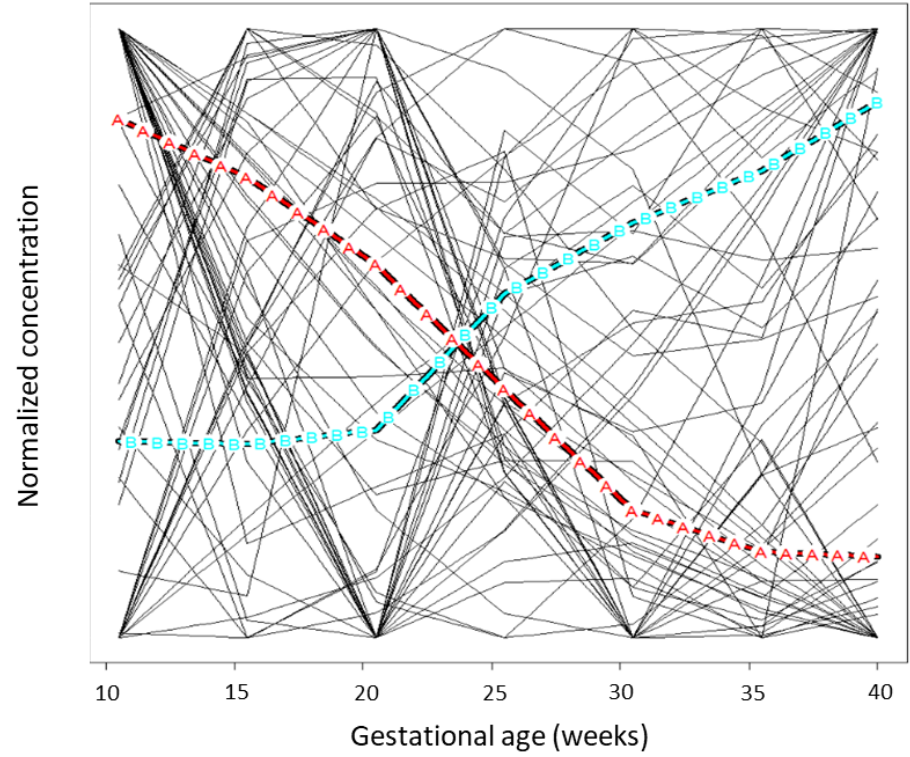
Figure 4. The two groups of trajectories (A, B) selected by the k-means for longitudinal data algorithm. The black lines behind the labeled trajectories represent the trajectories being grouped (1 trajectory per metabolite).